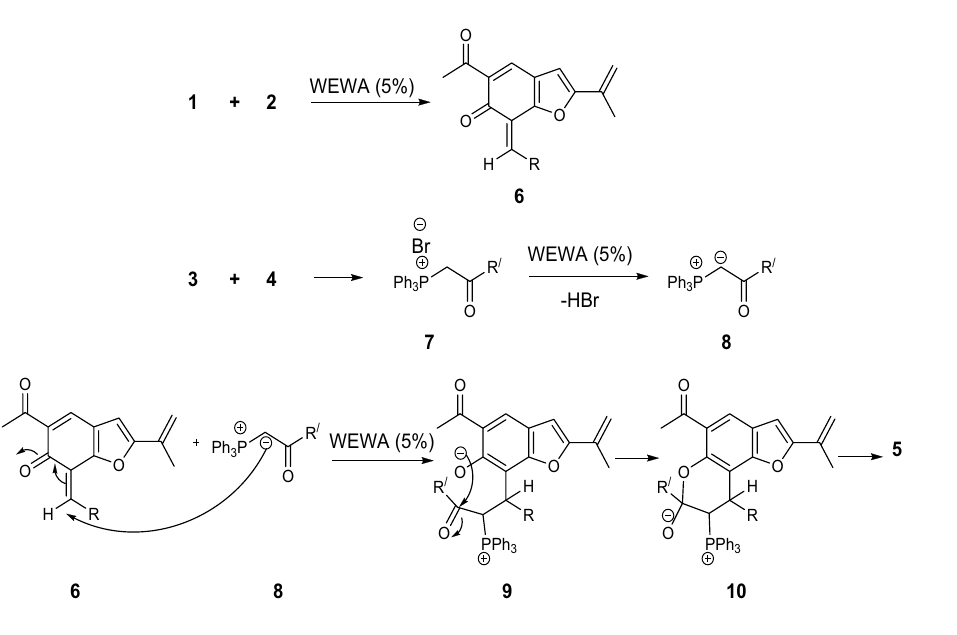
Figure 6. Proposed mechanism for the formation of 5